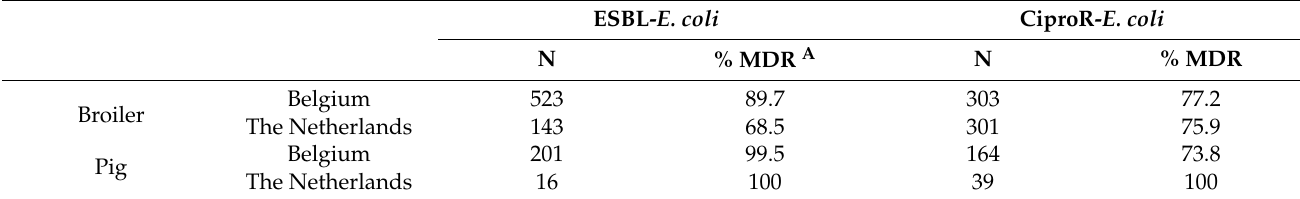
Table 3. Multidrug resistance in E. coli from broilers and pigs. Number of isolates tested (N) and the percentage (%) of MDR isolates. A total of 12 antibiotic agents were included per country, namely ampicillin, amoxicillin–clavulanic acid, piperacillin– tazobactam, cefoxitin, cefuroxime, ceftriaxone (Belgium)/cefotaxime (the Netherlands), ceftazidime, meropenem,